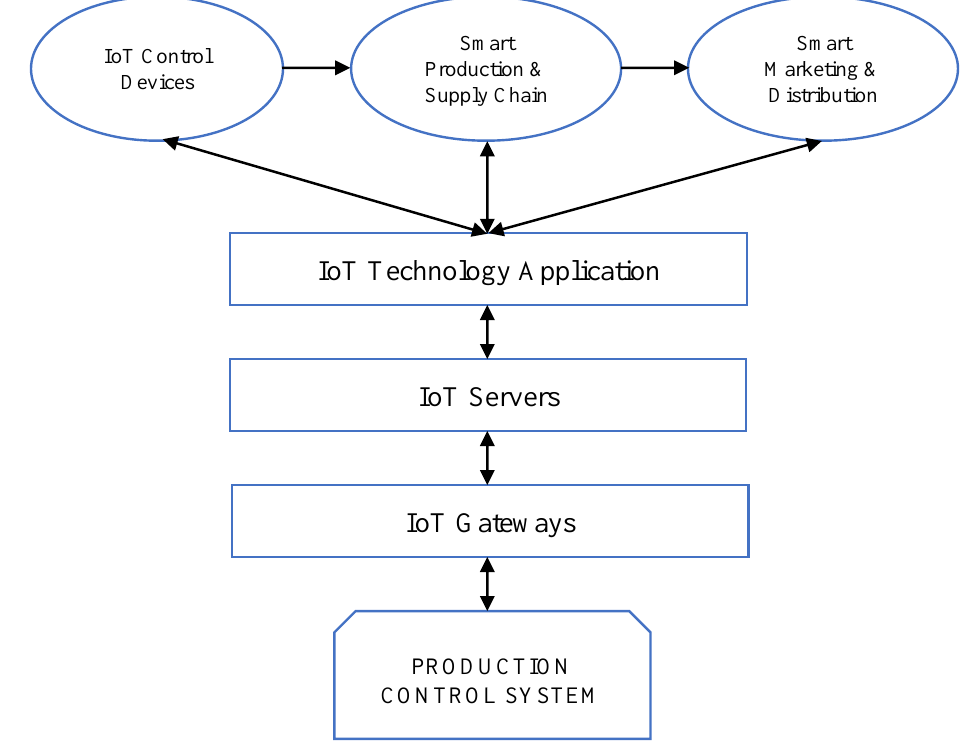
Figure 2. Proposed Conceptual IoT Production Structure (Adopted from Kumar et al.